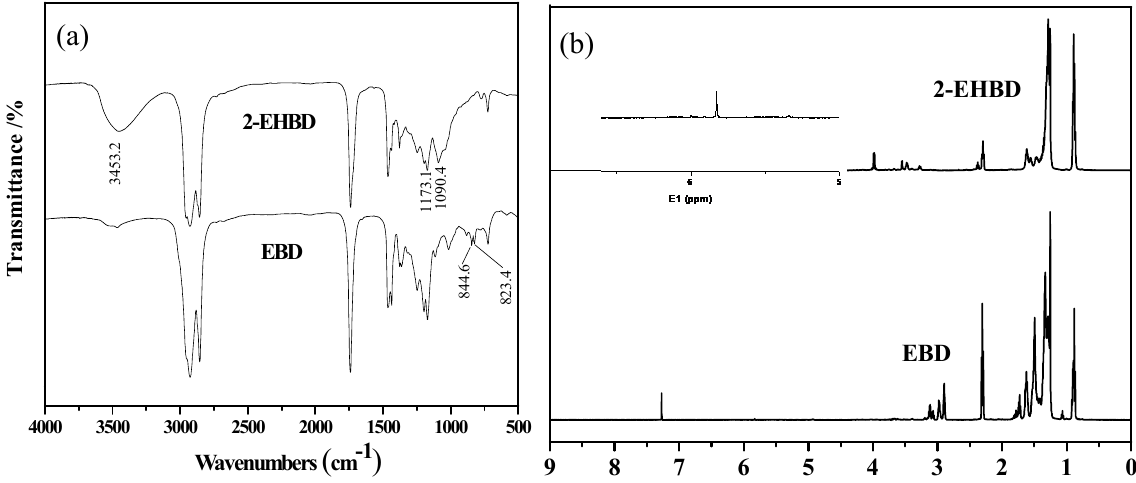
Figure 3. ( a ) FTIR spectra of the epoxidized biodiesel and the ring-opening product; ( b ) 1 H NMR spectral of the epoxidized biodiesel and the ring-opening product.